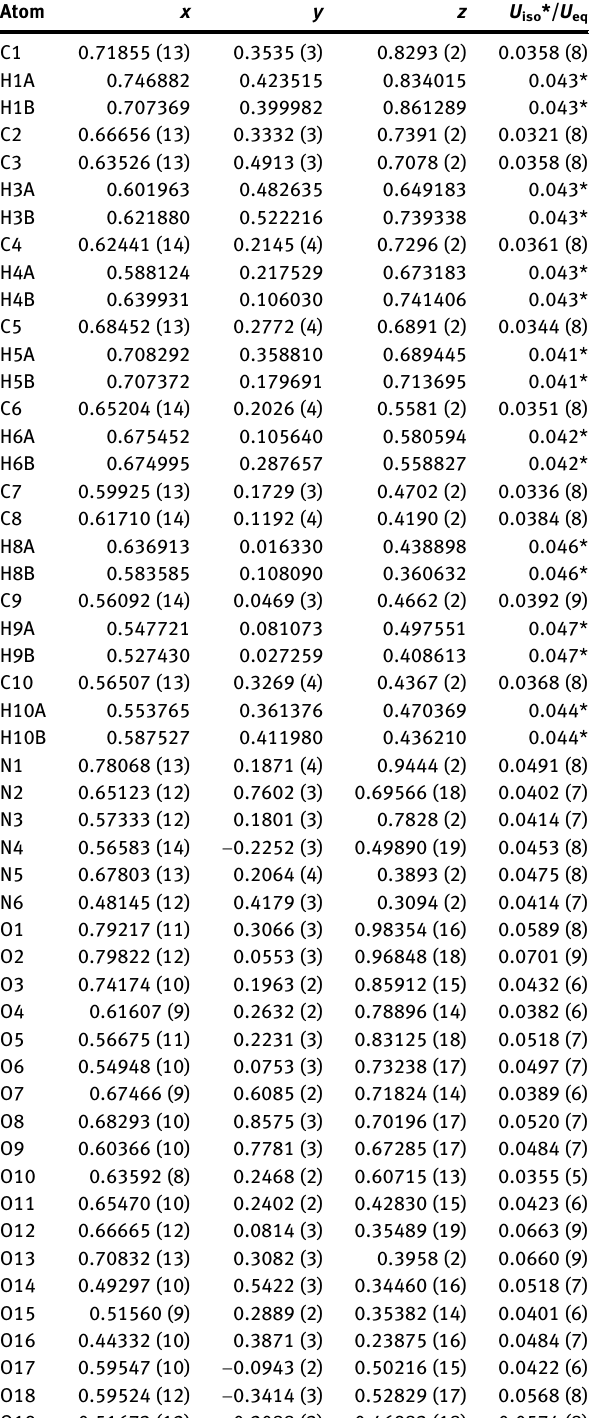
Table  : Fractional atomic coordinates and isotropic or equivalent isotropic displacement parameters (Å 